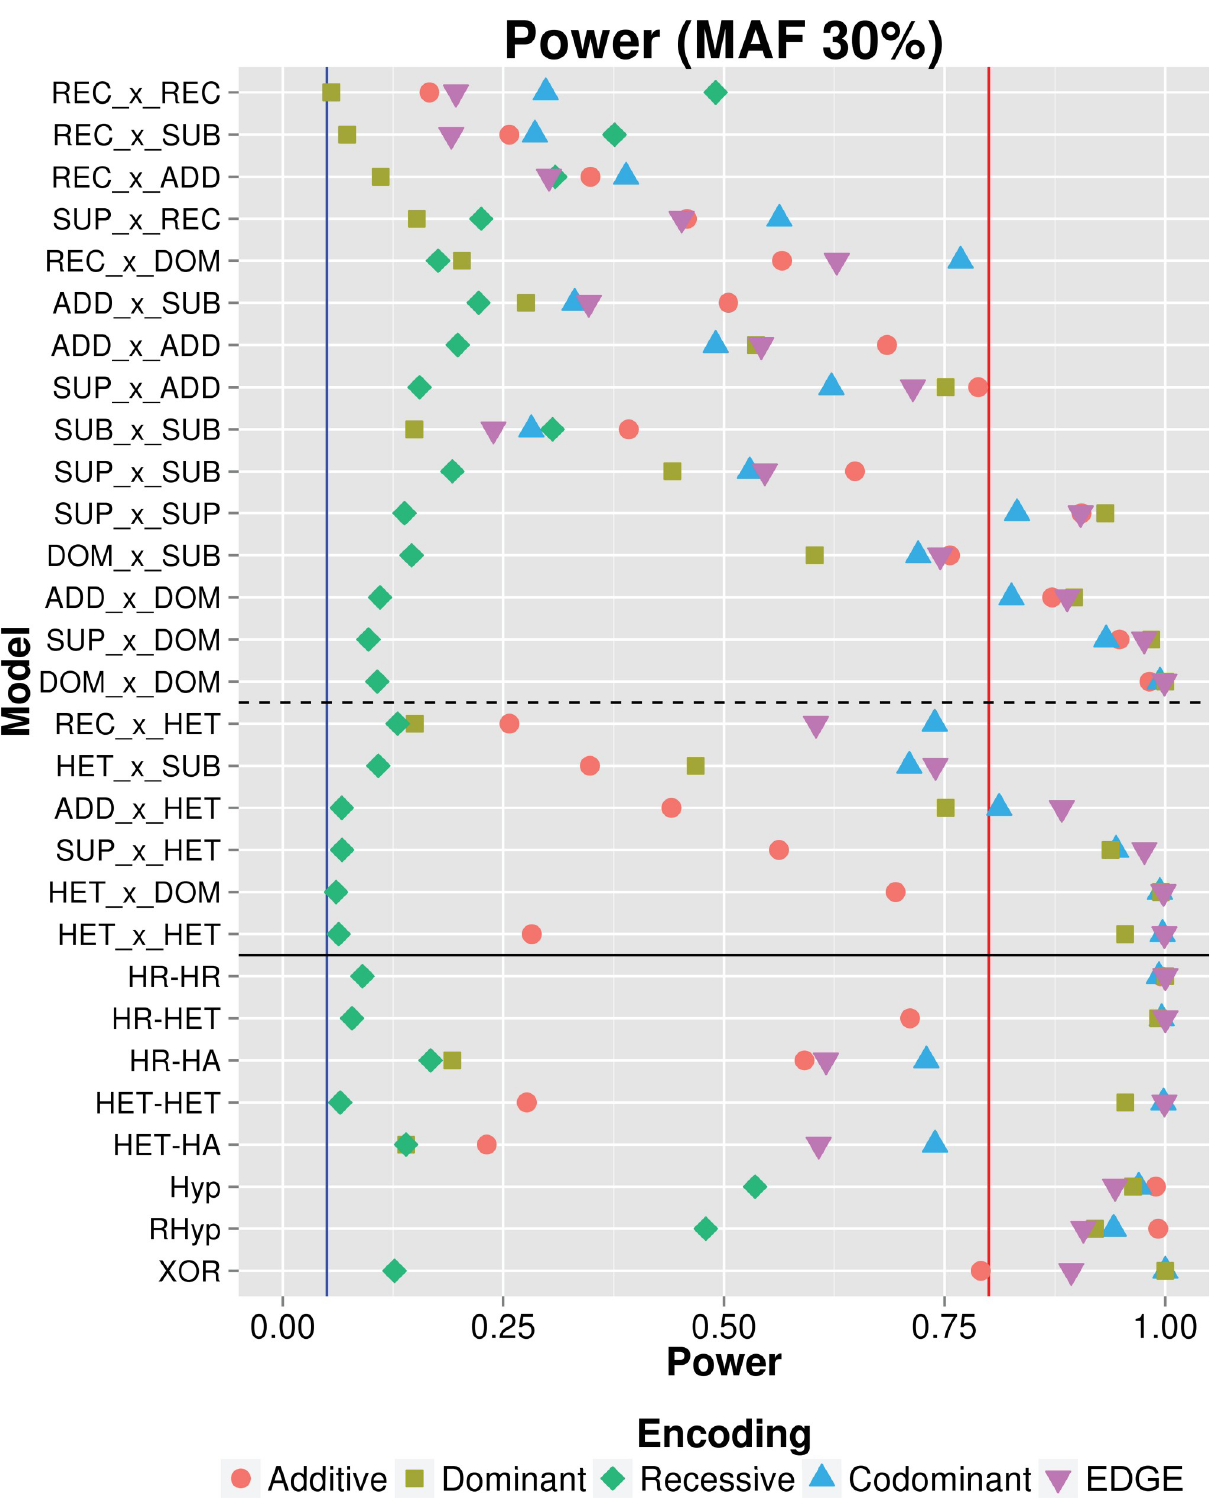
Fig 4. Results of power analysis across 29 simulated SNP-SNP interaction models. Power was calculated as the percentage of simulated models (out of 1,000 datasets for each model) for which the encoding detected an interaction signal at LRT p-value < 0.05: additive (red circle), dominant (yellow square), recessive (green diamond), codominant (blue triangle), and EDGE (purple inverted triangle). Twenty-nine SNP-SNP interaction models